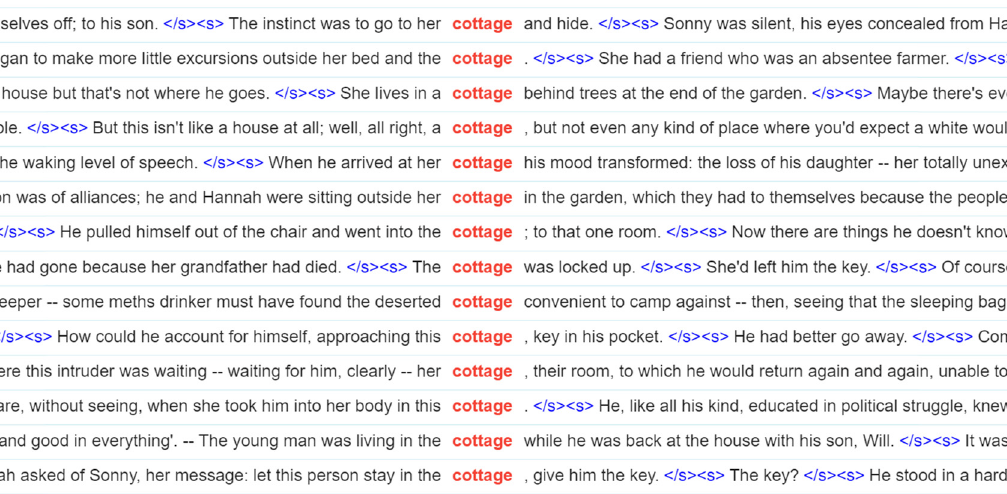
Figure 1: The keyword cottage in concordance